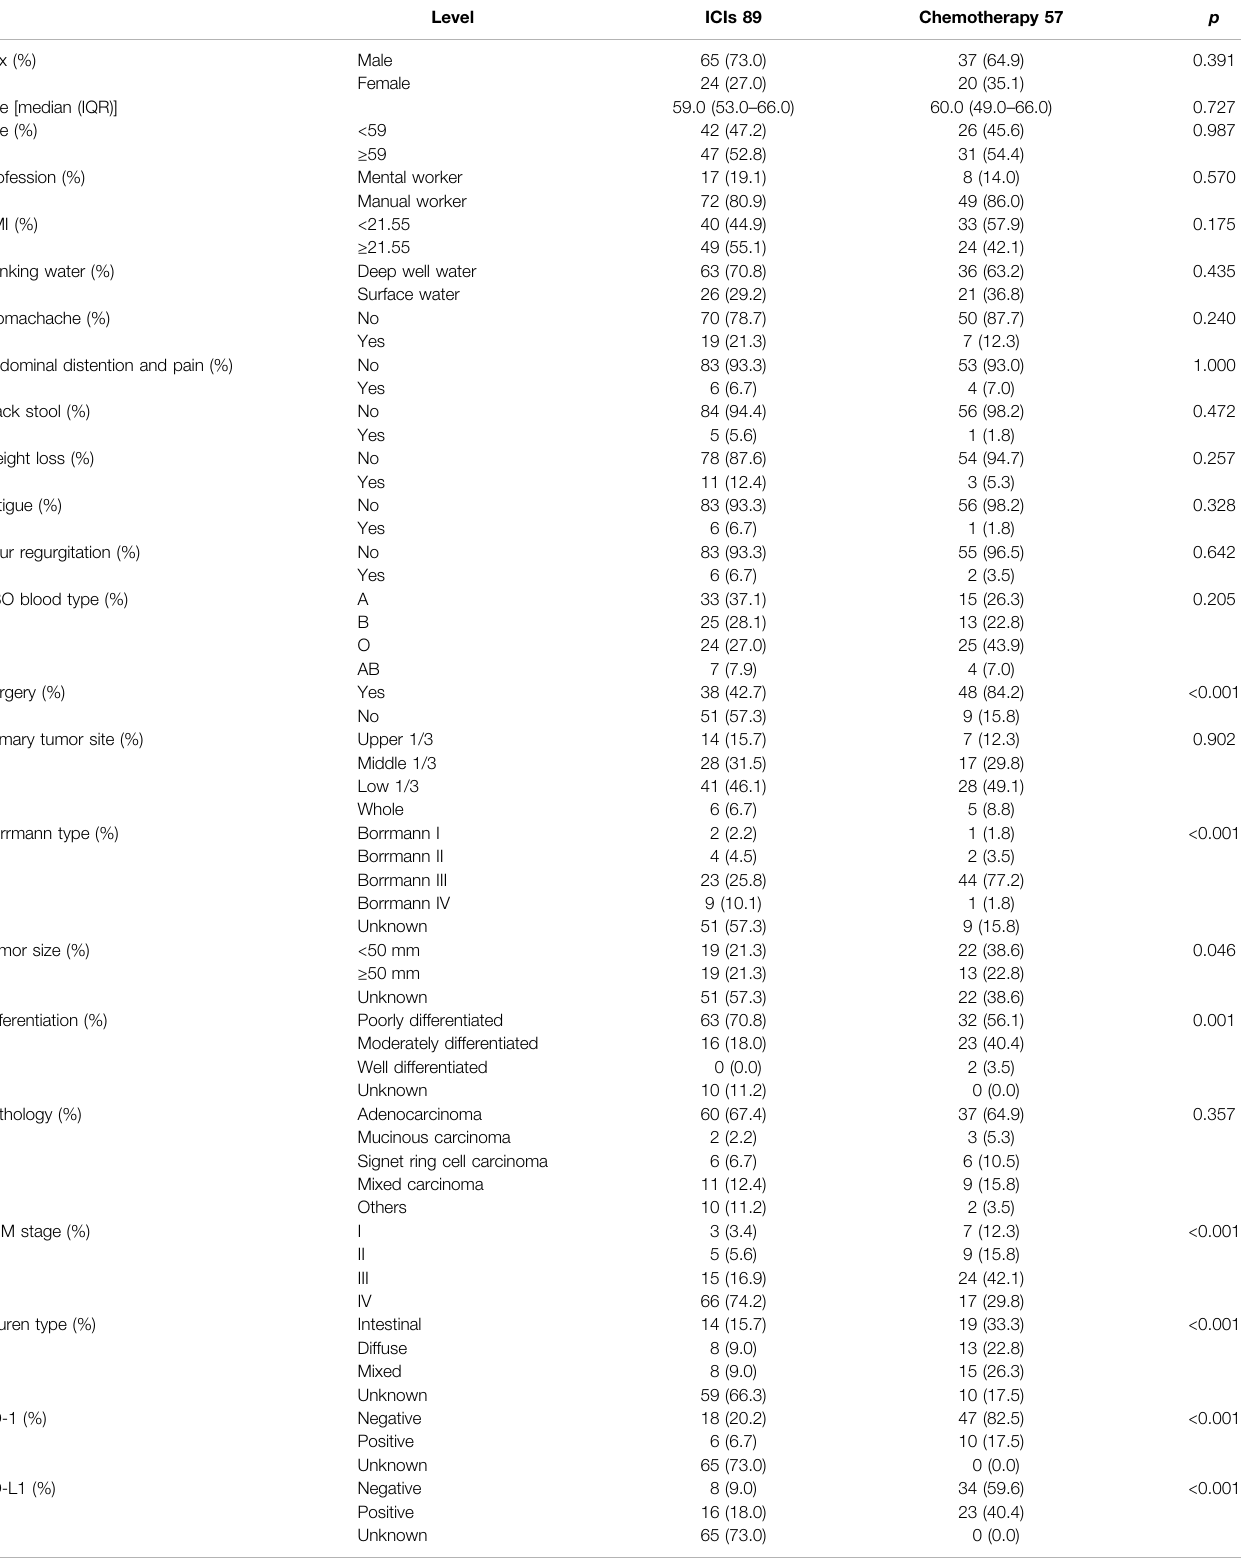
TABLE 4 | The clinical characteristics for treatment (ICIs and